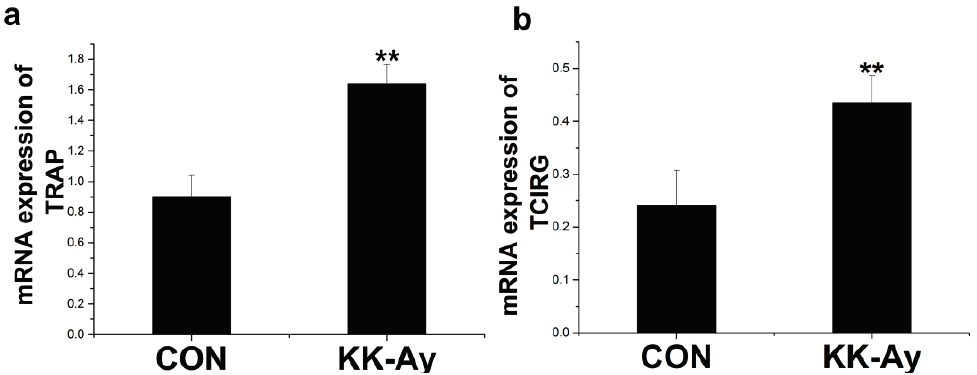
Figure 6. The expression of osteoclast-related genes in control (CON) and KK-Ay mice RNA was extracted from the bone of control and KK-Ay mice, reverse transcribed, and subjected to real-time PCR analysis. ( a ) mRNA expression of TRAP; ( b ) mRNA expression of TCIRG; n = 3–5, ** p < 0.01 vs. CON. The data are shown as the means ± SE.